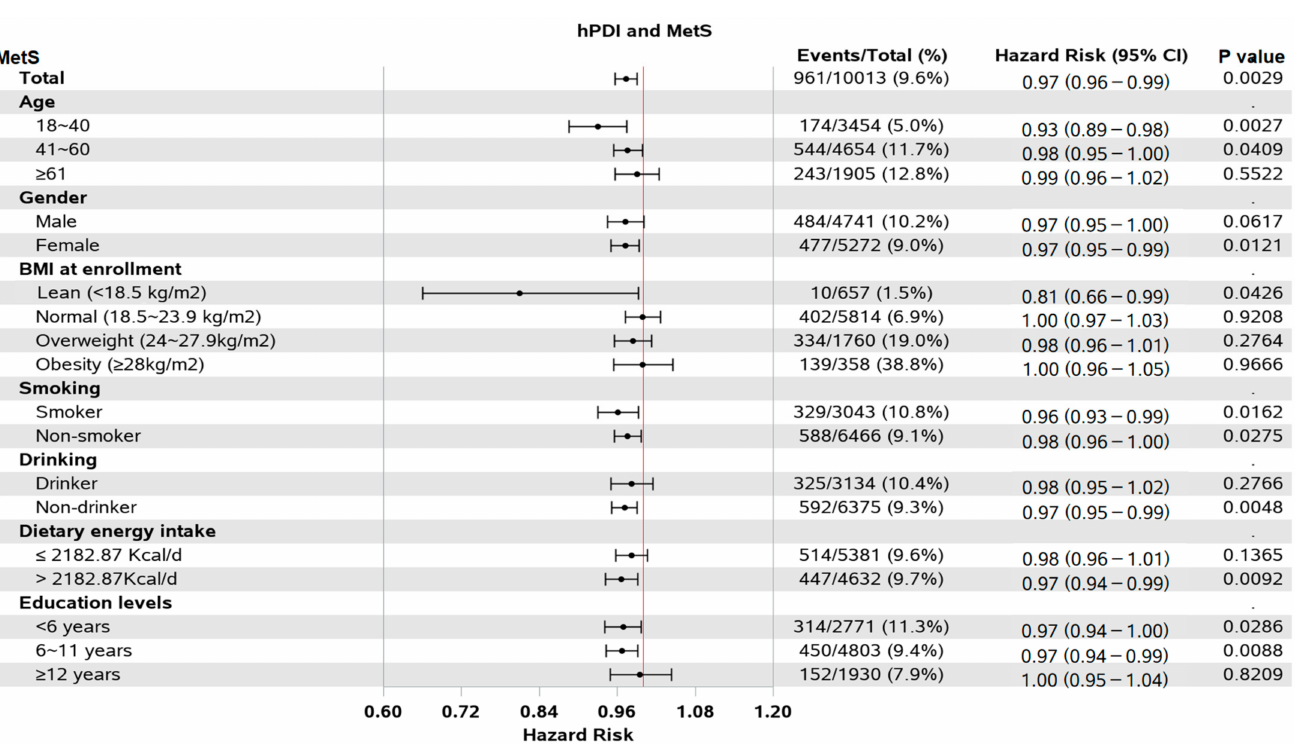
Figure 3. Forest plot of subgroups. The red line means that hazard ratio is equal to 1.hPDI, healthful plant-based diet index; MetS, metabolic